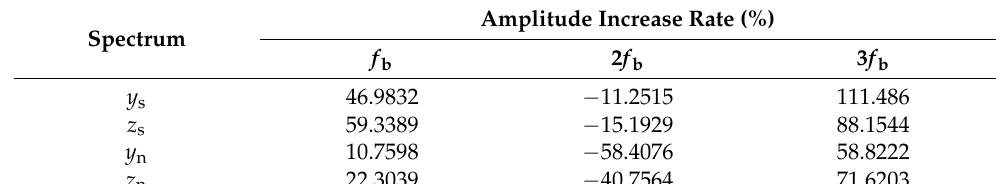
Table 2. Amplitude values around f b , 2 f b and 3f b .